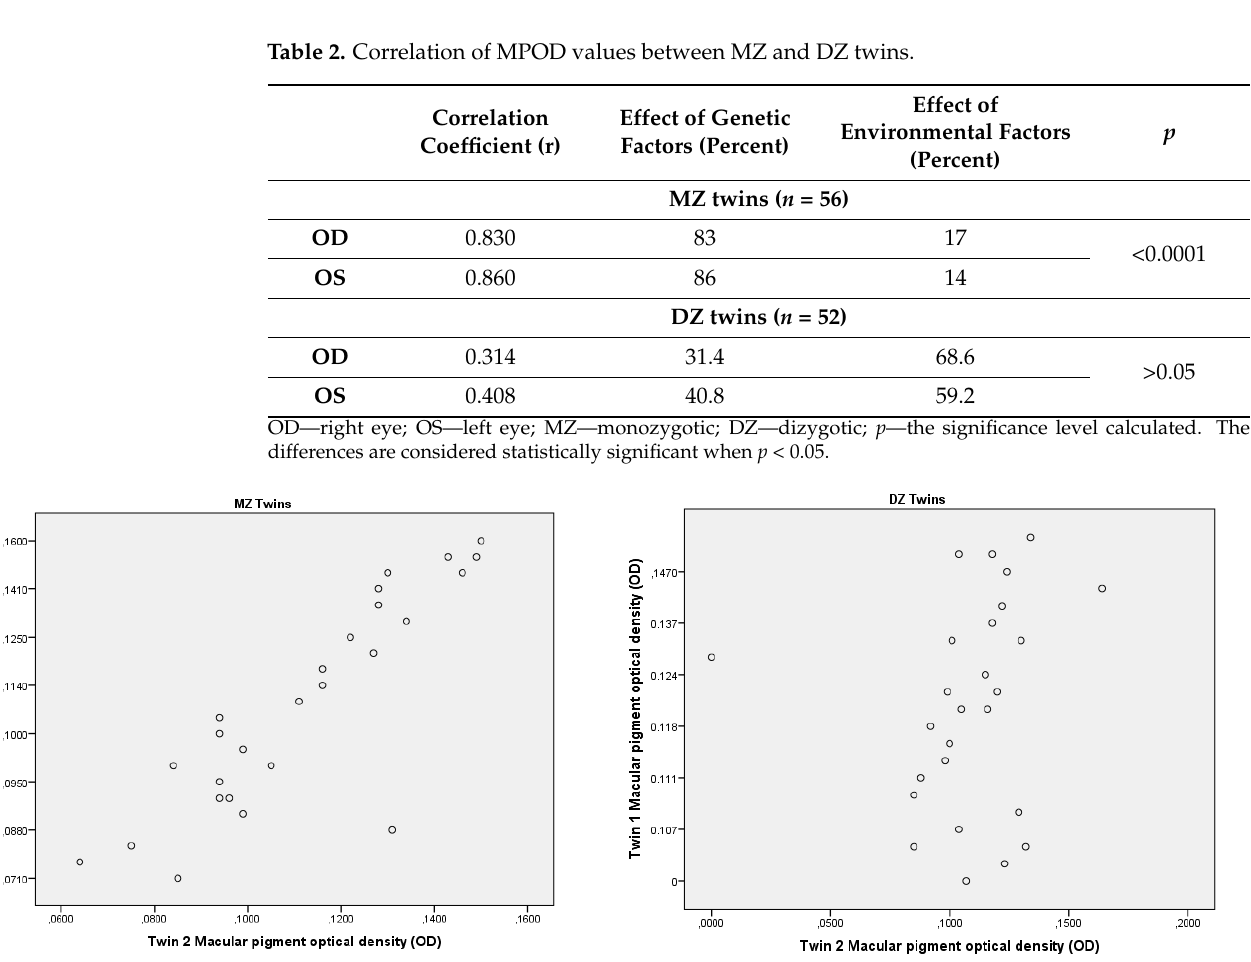
Table 3. Comparison of mean optical density and genotypes of SNP rs11057841 in SCARB1 gene. Samples